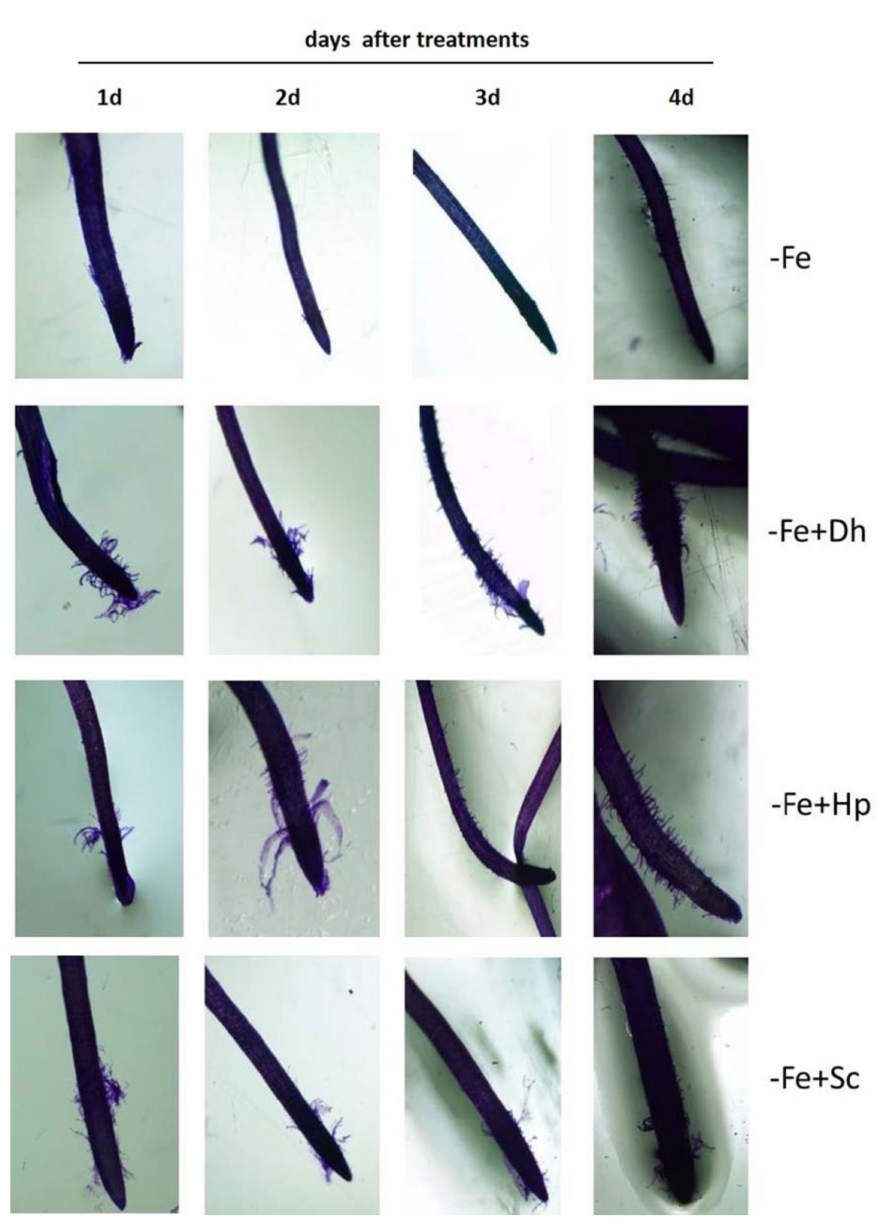
Figure 4. Analysis of development of subapical root hairs in young roots of cucumber plants grown without Fe (–Fe) or without Fe and inoculated with any of the three yeasts studied in this work: Debaryomyces hansenii ( − Fe+Dh), Hansenula polymorpha ( − Fe+Hp), or Saccharomyces cerevisiae ( − Fe+Sc). The inoculation with the yeasts was carried out the same day the Fe-deficiency treatment was applied. Roots were observed 1, 2, 3, and 4 days after treatments (1d, 2d, 3d, and 4d). The images were obtained using a stereoscopic microscope with camera system after having stained the roots with toluidine blue for 10